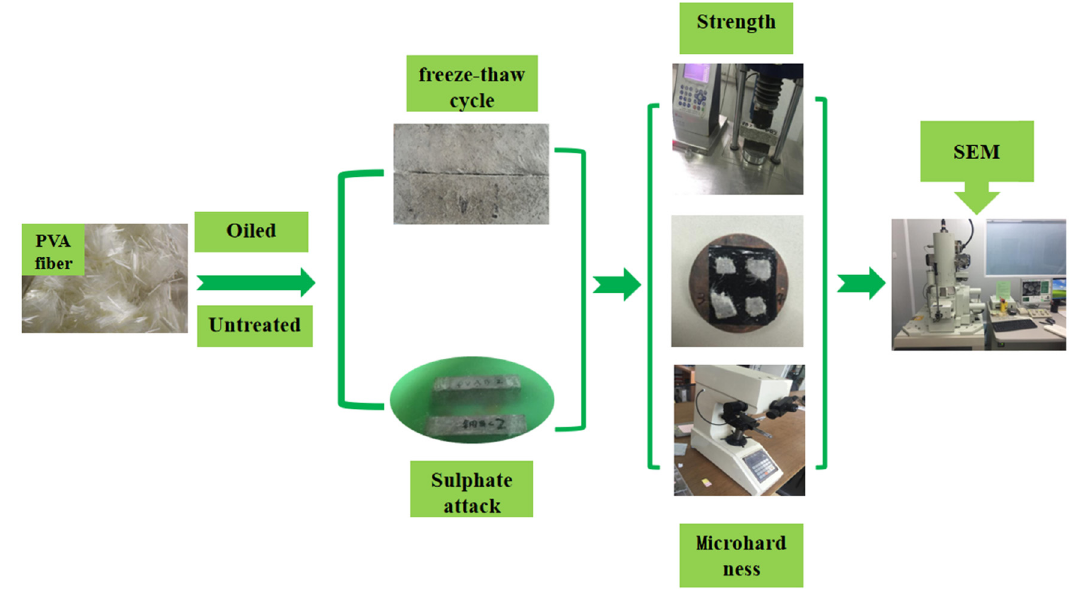
Figure 1: SHCC sample preparation and performance